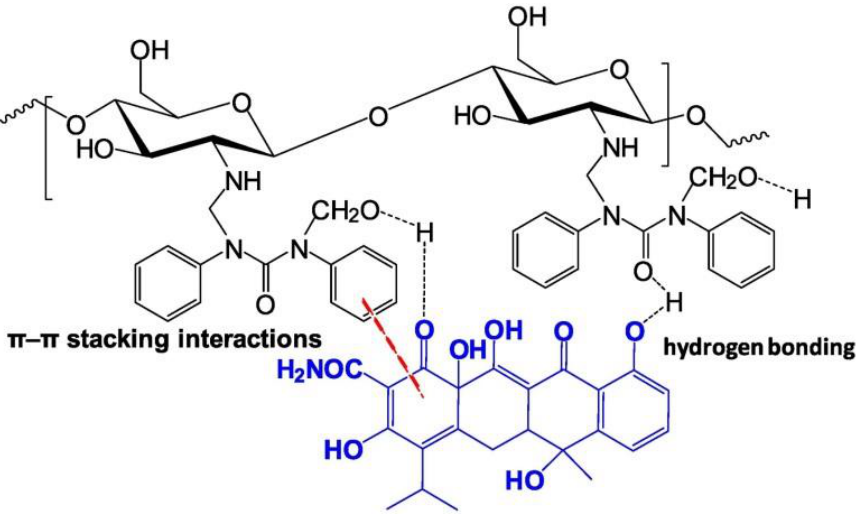
Figure 14. Mechanism of adsorption for TC onto CDF@MF [19]. Figure 12. Mechanism of adsorption for TC onto CDF@MF